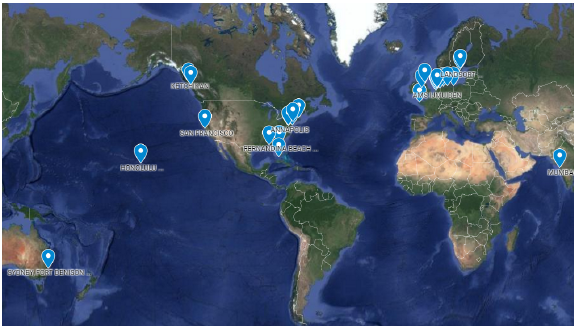
Figure 1: The locations of the 27 tide gauge stations used in this study are indicated with drops (Google map,